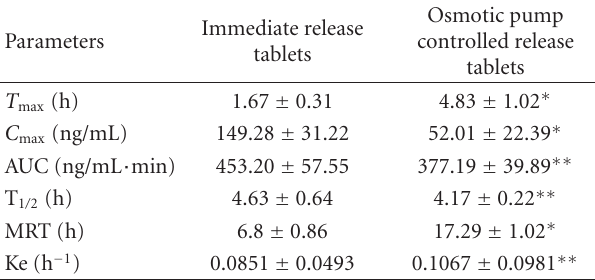
Table 5: The pharmacokinetic parameters (vinpocetine metabolite apovincaminic acid) in dogs after oral administration of 15mg release-tablets (average ± SD, n =